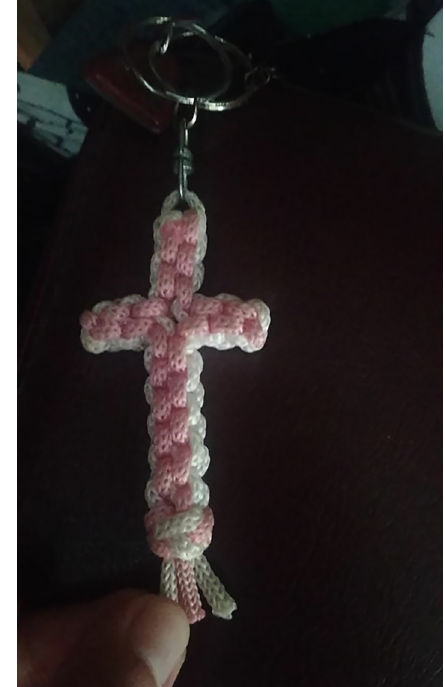
A Cross, Illustration on How Christianity Inspires